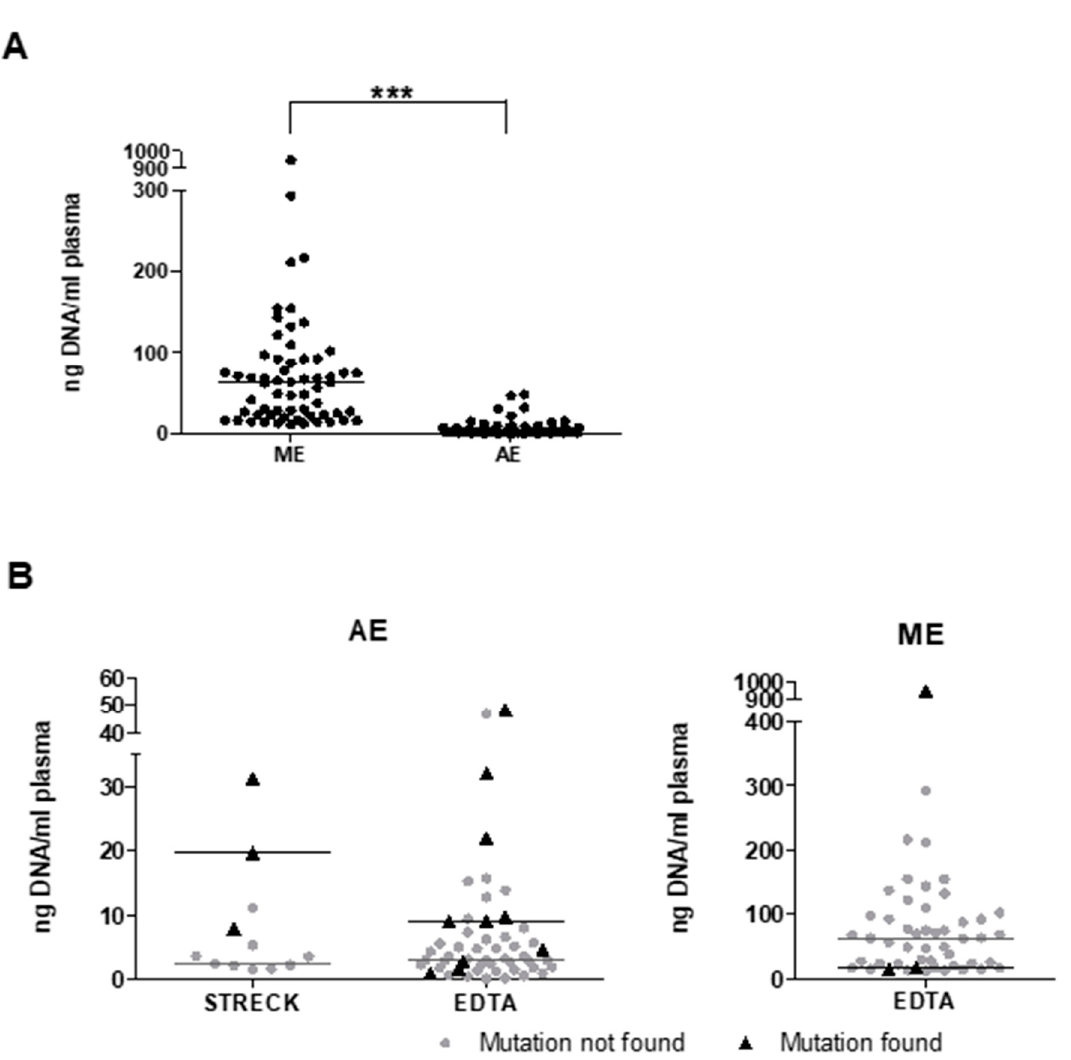
Figure 2. Manual and automated extraction leads to different cfDNA concentrations. ( A ) cfDNA content in automatically and manually extracted (AE; ME) cfDNA of directly processed EDTA- sampled plasma were significantly different (***: p < 0.0001). ( B ) Following AE, cfDNA concentrations are higher in mutation-positive samples compared to negative samples. Opposite results were observed in ME cfDNA samples. Horizontal lines: median for specific groups.